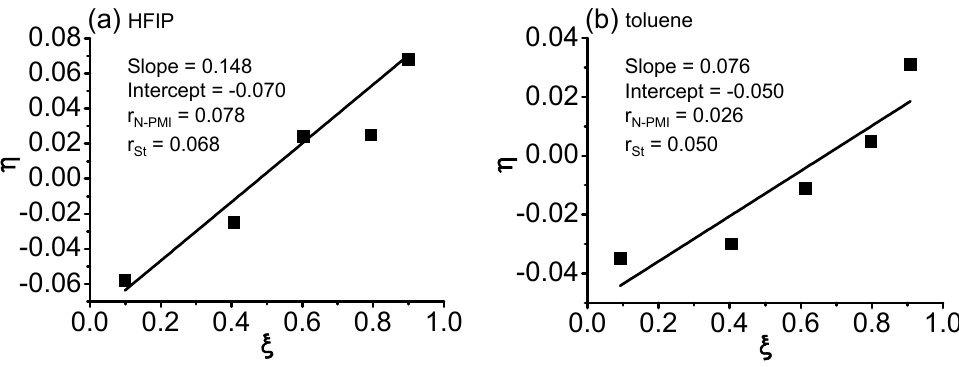
Figure 3. Reactivity ratios of N-PMI and St via Kelen–Tüdõs method for the RAFT polymerization at 40 °C. ( a ) HFIP as solvent ( b ) toluene as solvent.